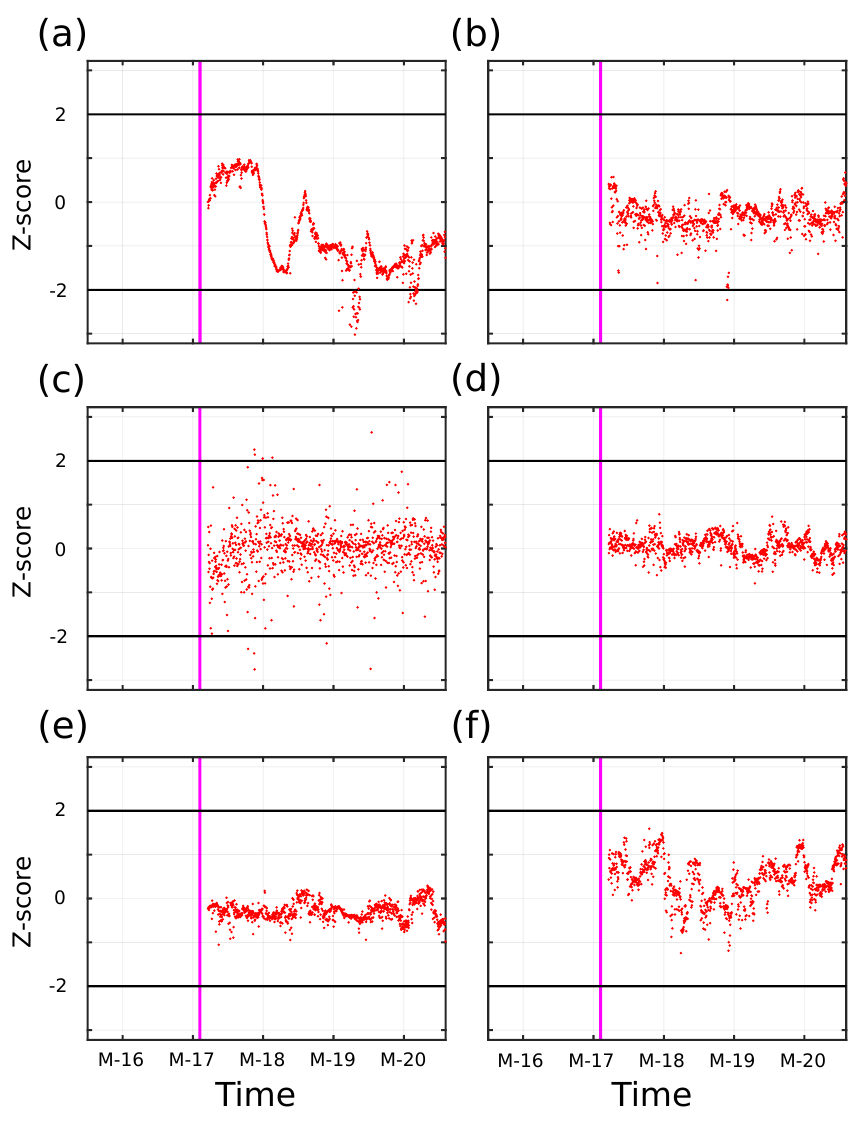
Figure 7. Same as Fig. 6 but for